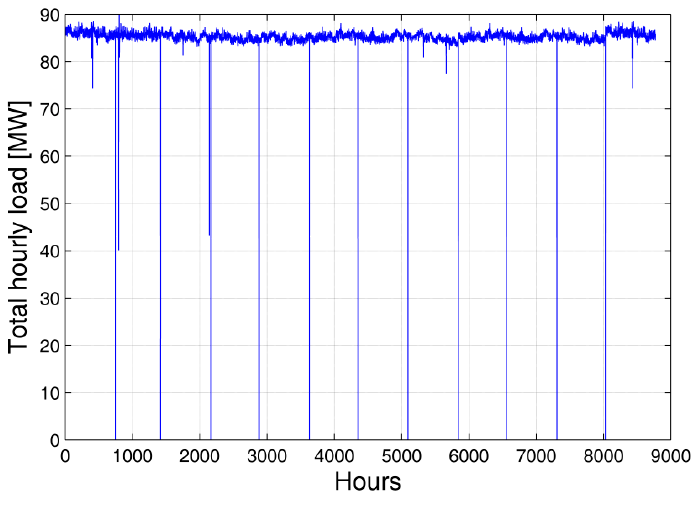
Figure 1. Annual diagram of energy consumption in the KAP.